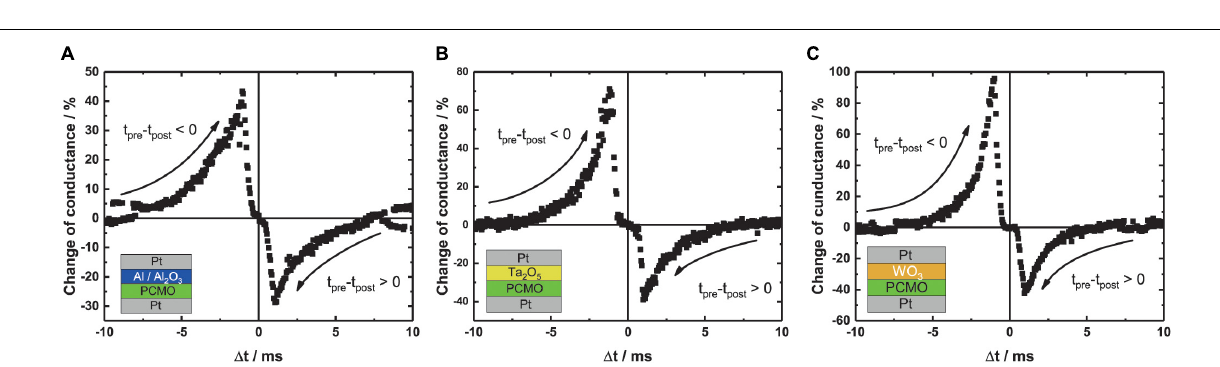
FIGURE 3 | Relative change of conductance for different time delays between the pre- and post-synaptic pulse during STDP measurement for the three different devices. (A) Al/Al 2 O 3 , (B) Ta 2 O 5 , and (C) WO 3